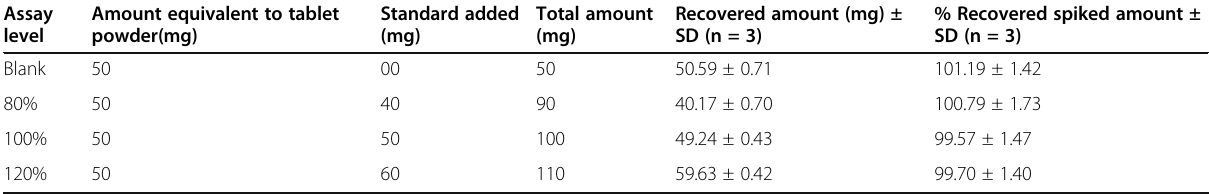
Table 6 Recovery of ceftriaxone sodium Assay Amount equivalent to tablet level